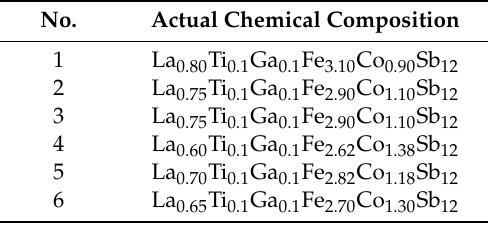
Table 1. The actual chemical compositions of the bright and dark areas in the annealing sample. No.